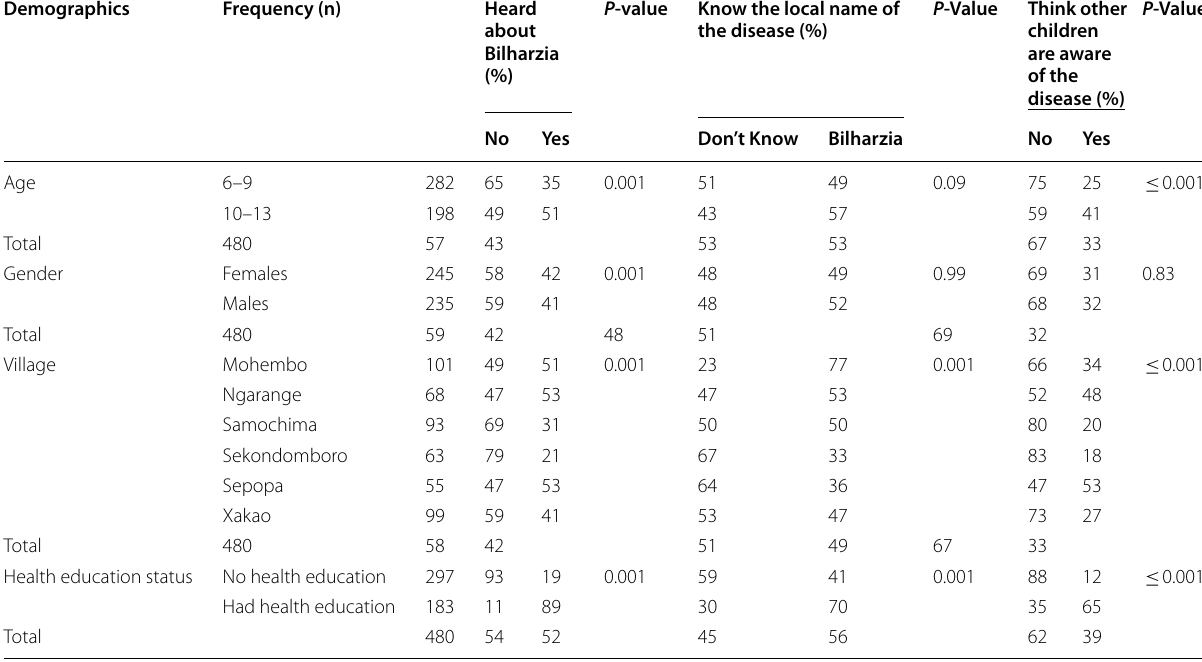
Table 3 Awareness of Schistosomiasis by demographic characteristics